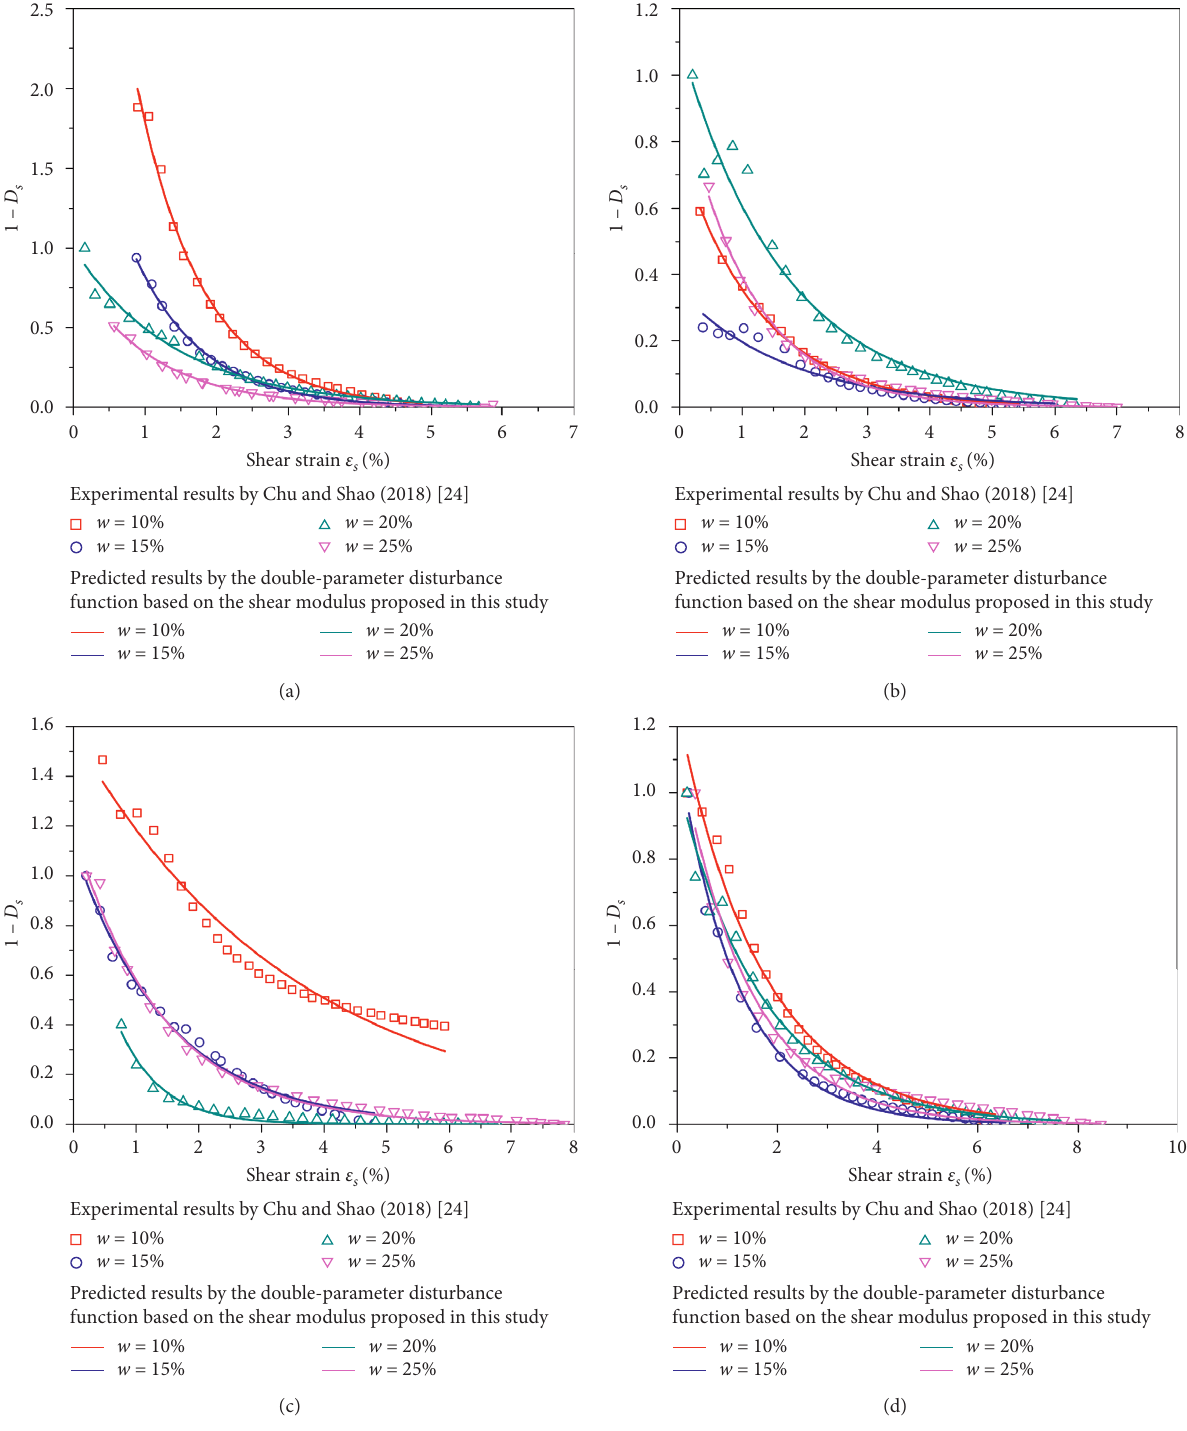
Figure 11: Validation of the double-parameter disturbance function based on shear strain against the experimental results by Chu and Shao [24] at different moisture contents and confining pressures. (a) σ 3 � 100 kPa; (b) σ 3 � 200kPa; (c) σ 3 � 300kPa; (d) σ 3 �